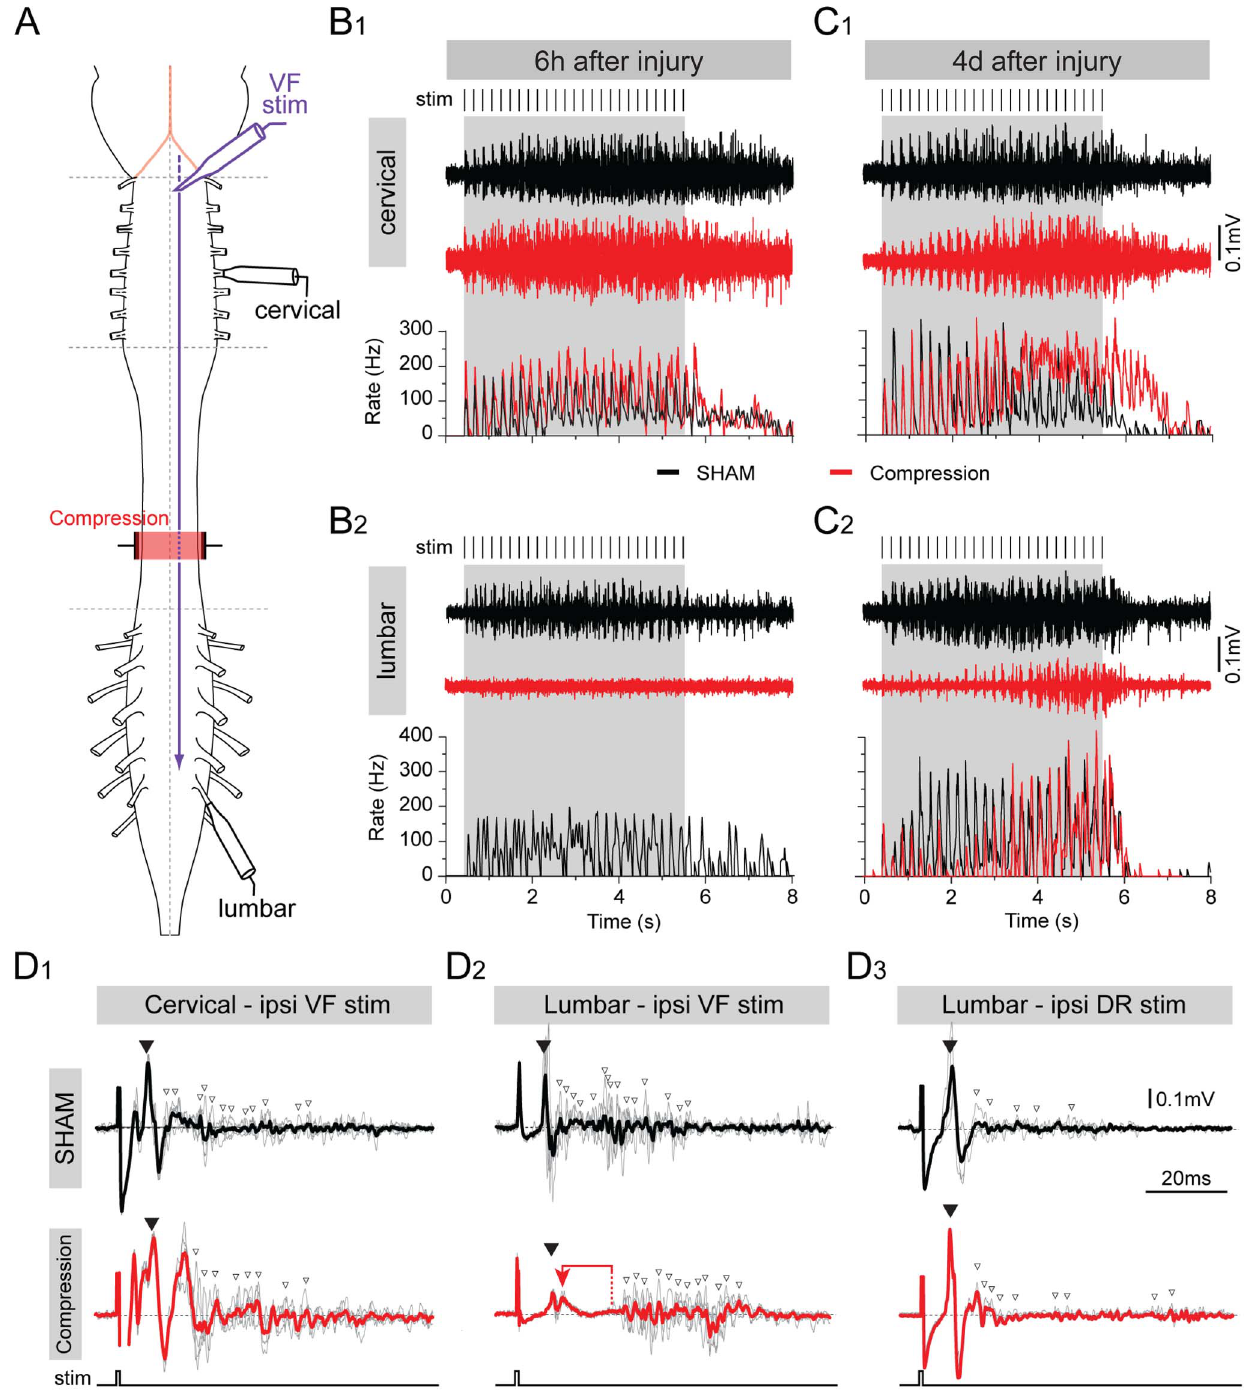
Figure 6. Recovery of responses to general bulbospinal pathway stimulation following SCC, assessed with electrophysiology. (A) Schematic of the ex vivo preparation of the brain stem and spinal cord showing the site of bulbospinal pathway stimulation in the ventral funiculus (VFstim), the compressed region (red zone) and the recording suction electrodes placed on cervical (above the injury) and lumbar (below the injury) ventral roots. (B and C) Ventral root responses during stimulus trains (grey box, 25 pulses over 5 s, individual stimulus pulses indicated above) in cervical (B1, C1) and lumbar (B2, C2) ventral roots in 6 h post-surgery sham control (B, black traces), 6 h post-injury SCC (B, red traces), 4 day post- injury sham control (C, black traces), and 4 day post-injury SCC mice (C, red traces). Upper traces show raw recordings, graphs show instantaneous spike firing rates. (D) Tight seal recordings from cervical (D1) and lumbar (D2,3) ventral roots following single pulse stimulation of the ventrolateral funiculus (D1, D2) or the lumbar dorsal root (D3) in sham control (black traces) and SCC mice 4 days after surgery/injury. Filled black arrowhead indicates the monosynaptic component of the response, open arrowheads indicate polysynaptic components. The red arrow in D2 shows the increased delay between monosynaptic and first polysynaptic component 4 days post-injury.